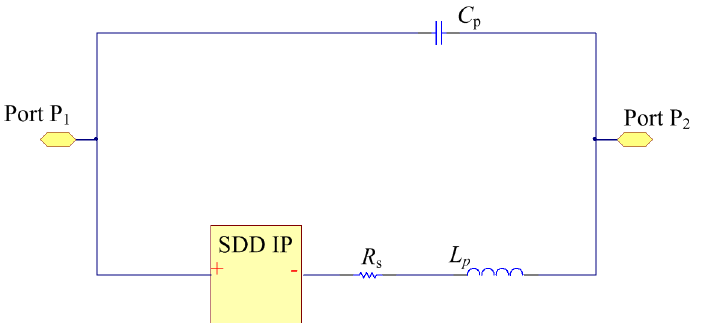
Fig 5. Spice model of the SRD.